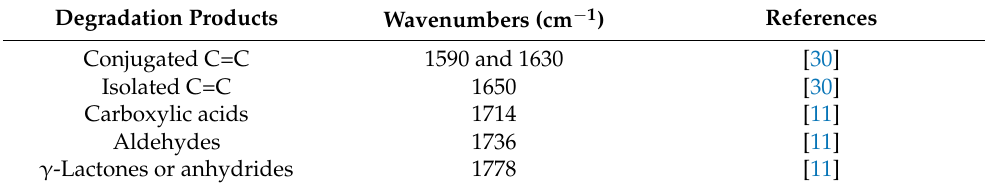
Table 3. Main degradation products detected by FTIR spectroscopy during the radio-thermal ageing of the Si-XLPE